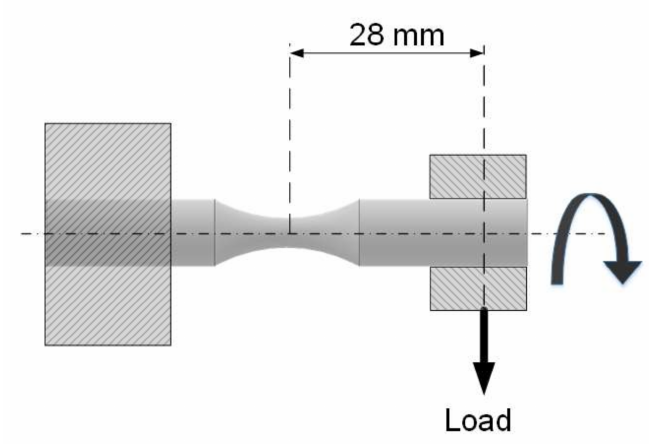
Figure 3. Rotating bending fatigue machine